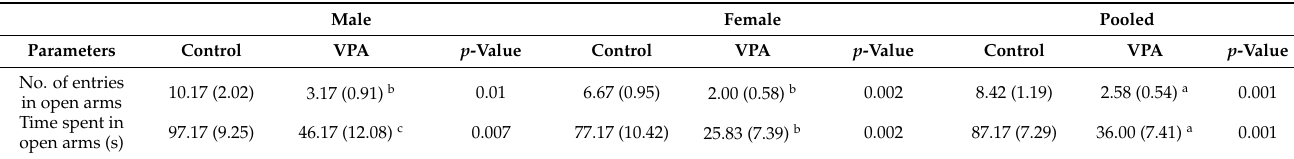
Table 1. Effect of VPA on anxiety using elevated plus maze apparatus.